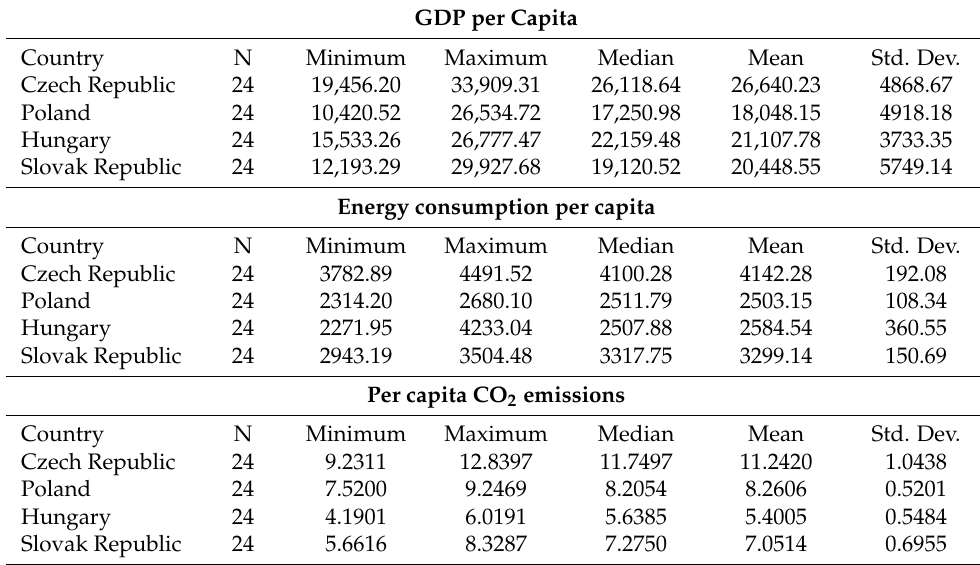
Table 1. Descriptive